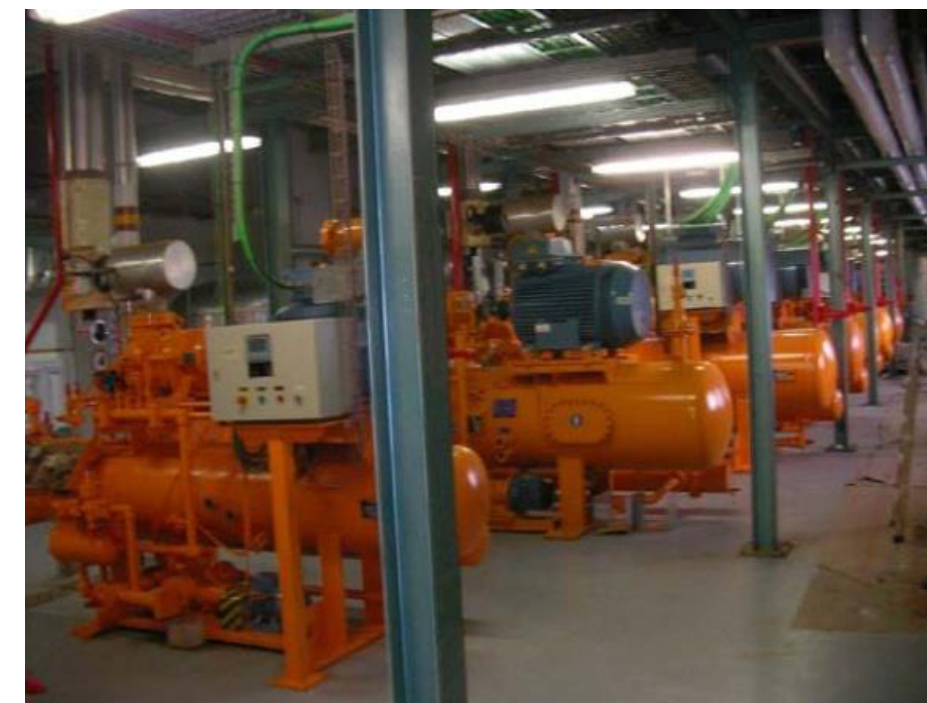
Figure 5. View of industrial refrigeration compressor room under study.